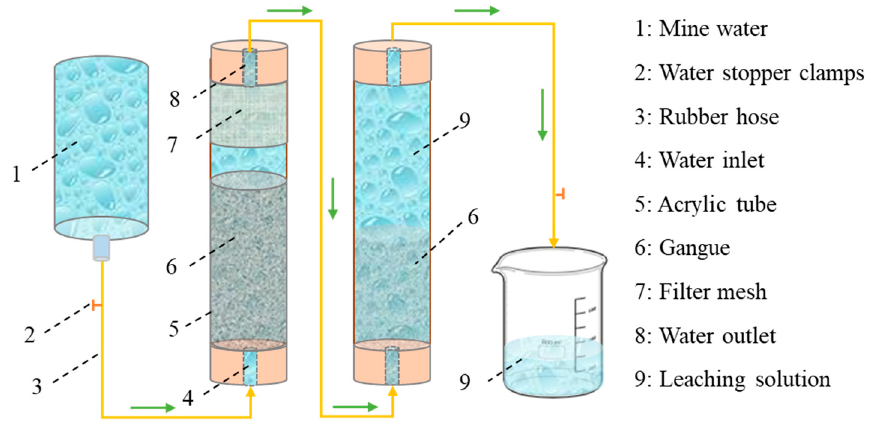
Figure 1. Dynamic leaching experiment. Table 2. Dynamic leaching test